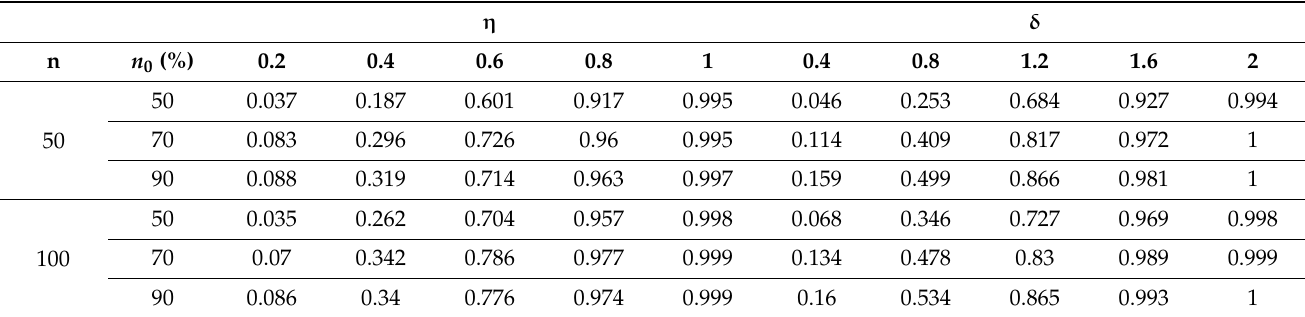
Table 2. Results of power estimates (1-Type II error) for variation in shape ( η ) and magnitude ( δ ), in the case of independence between curves and considering θ =